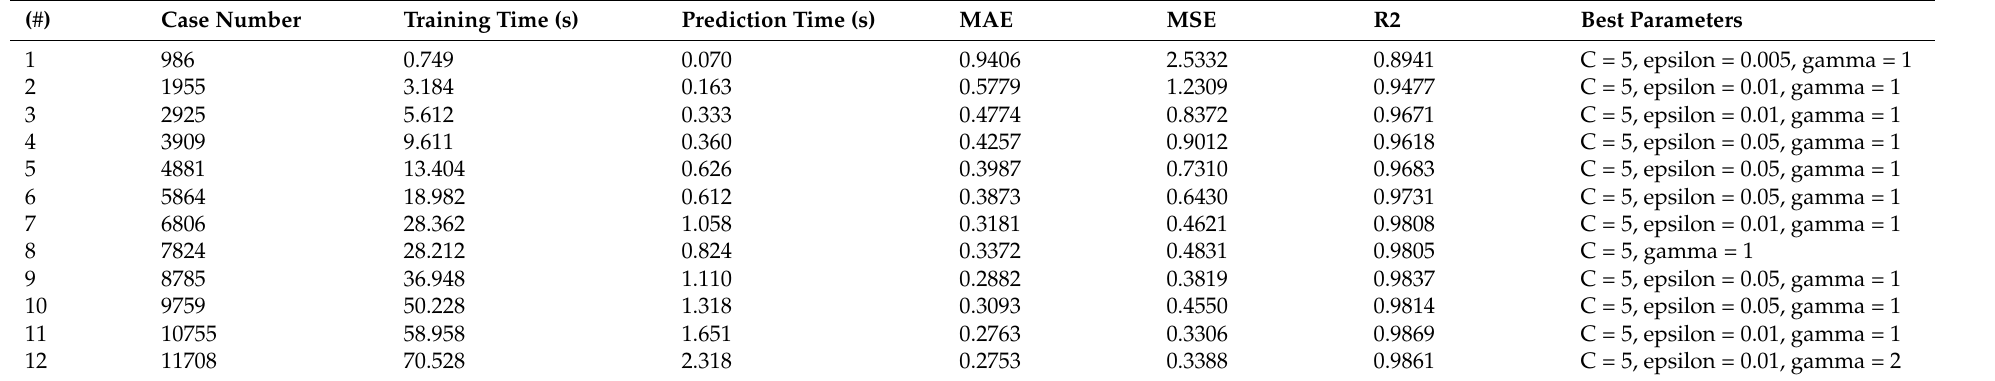
Table A5. Results of running the model with: SVR.